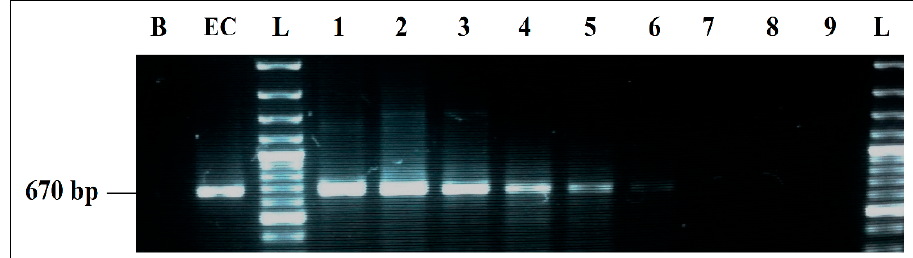
Figure 2. Detection sensitivity of E. coli primers GADA 670 bp in simplex PCR. B, negative control; EC, positive control E. coli 101 CECT; L, 100 bp DNA ladder; lane 1 to 6, PCR results from 6078 pg/ µ L to 0.06 pg/ µ L DNA; Lane 7 to 9, PCR results from 0.006 pg/ µ L to 0.00006 pg/ µ L DNA; L, 100 bp DNA ladder.